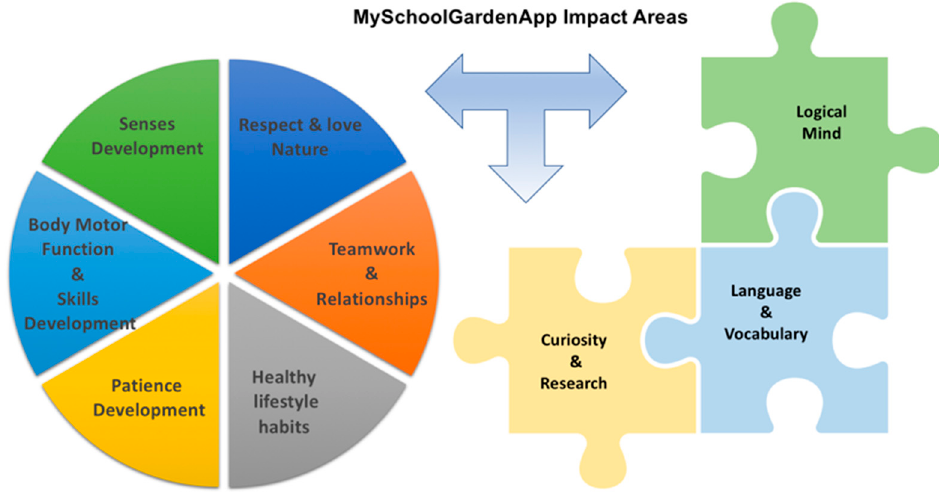
Figure 10. MySchoolGardenApp Impact Areas.